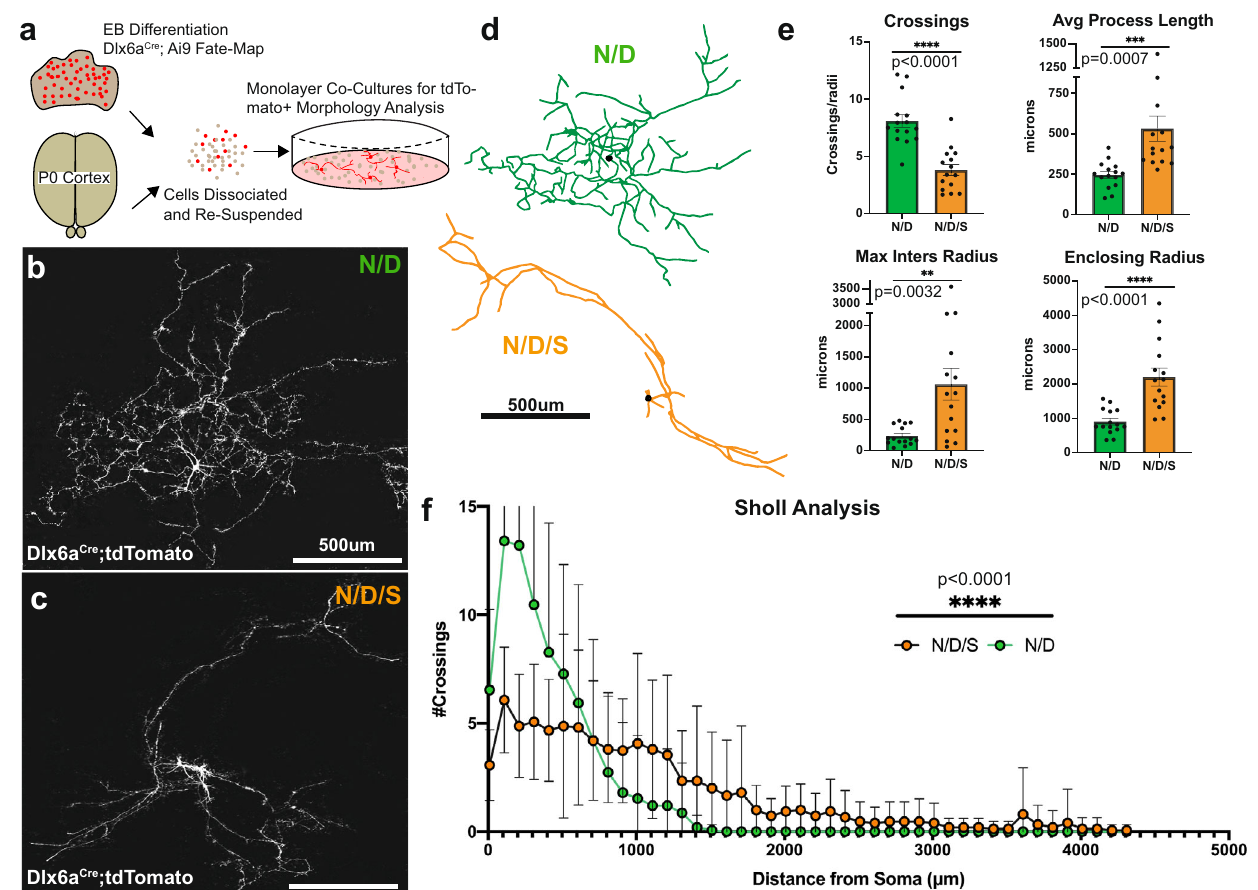
Fig. 3 | St18 GOF produces projection-like neuronal morphologies. a Experimental design of 2D monolayer tracing experiments. N/D and N/D/S lines are differentiated into EBs and dissociated into single-cell suspensions. Con- cordantly, P0 corticies are dissociated and combined with low-density EB suspen- sions for plating and whole-cell tracing following fate-mapping (Dlx6a Cre ; Ai9). b Sample N/D neuron plated at low density with fate-mapping (Dlx6a Cre ; Ai9). c Sample N/D/S neuron plated at low density with fate-mapping (Dlx6a Cre ; Ai9).